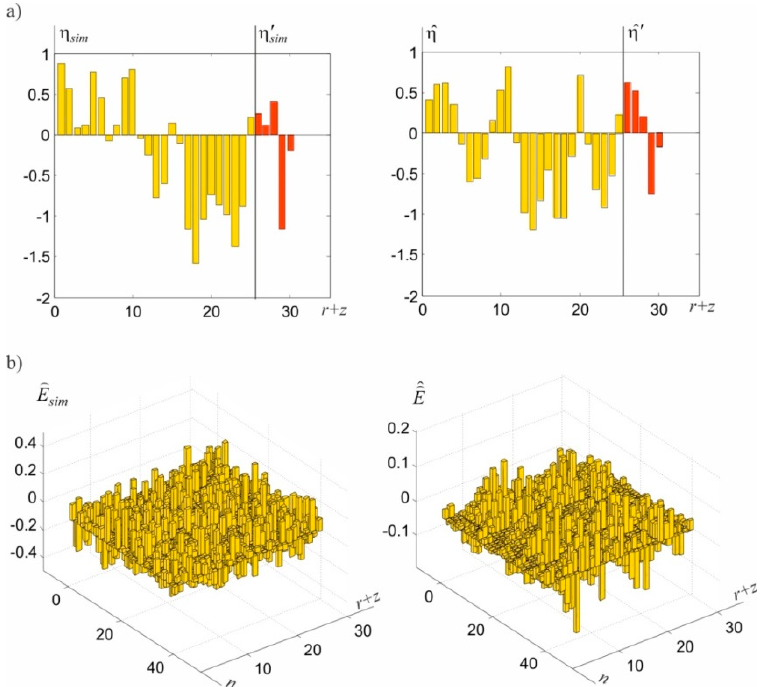
Figure 5. Graphic illustration of estimation results: ( a ) simulated and determined random Figure5. Graphicillustrationofestimationresults: ( a )simulatedanddeterminedrandomdisplacements